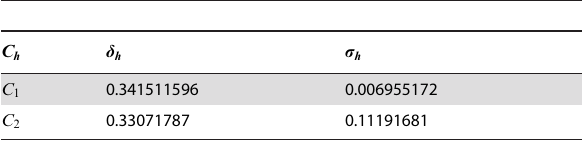
Table 7. NetSel extracted communities within distance and relative standard deviation.